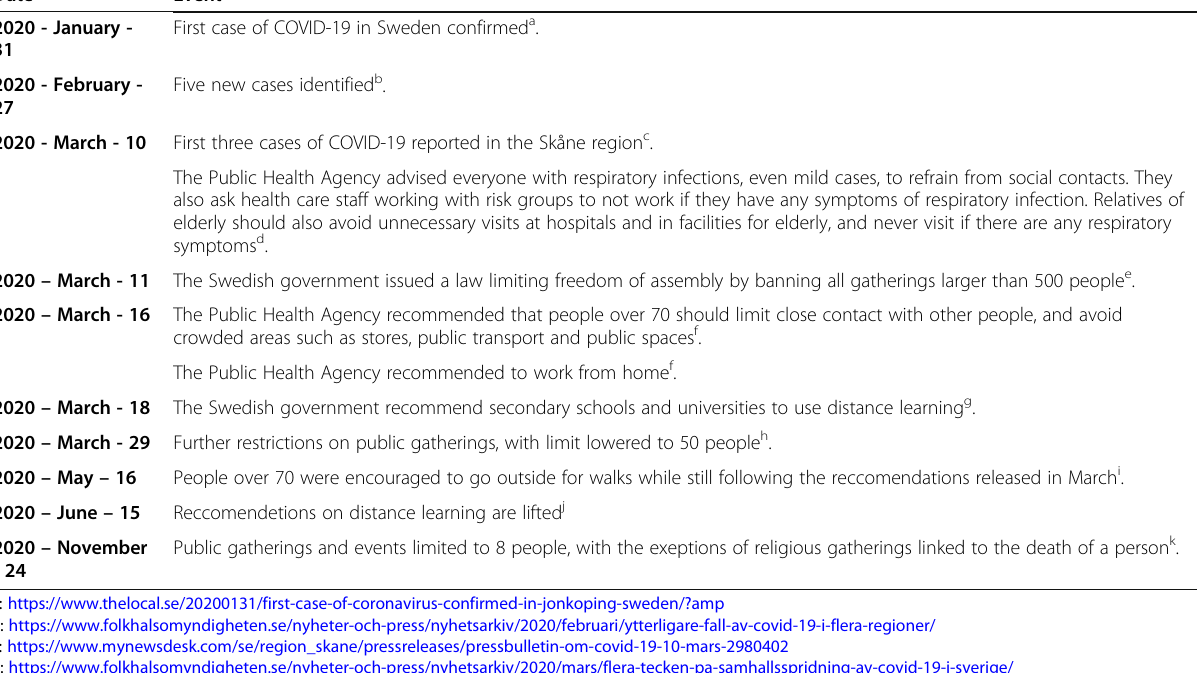
Table 1 Timeline of the COVID-19 pandemic in